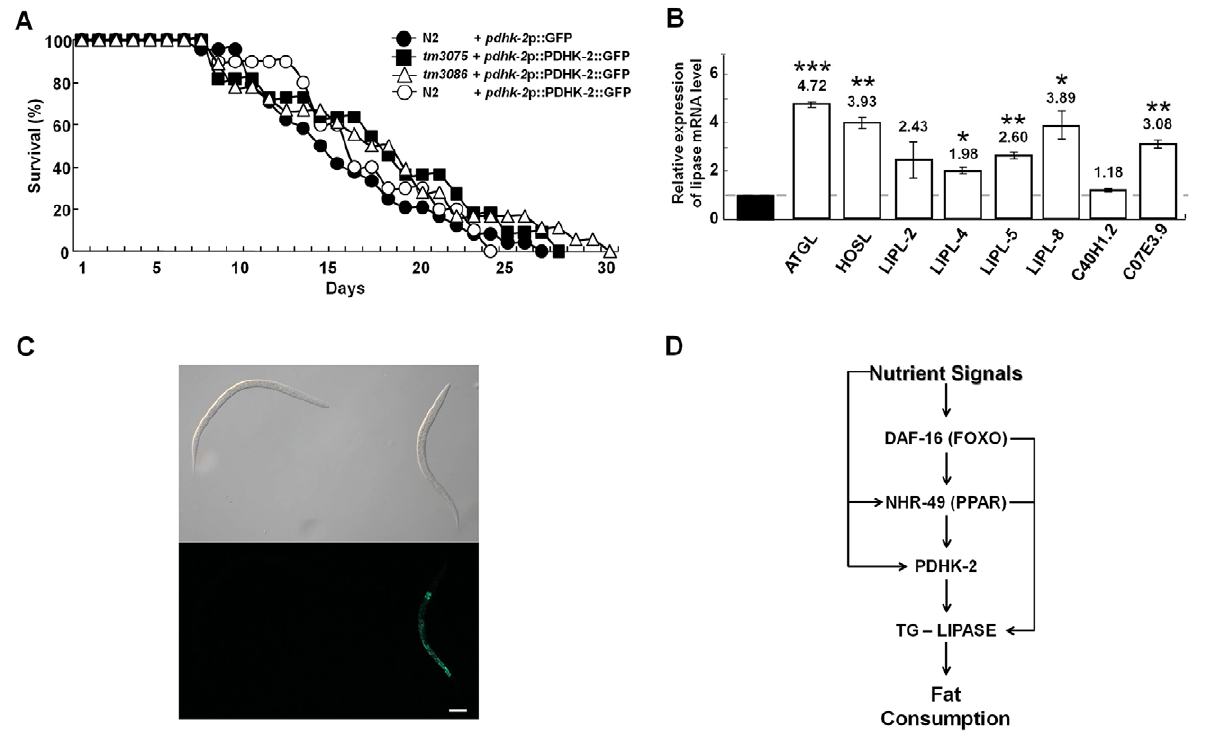
Figure 5. Effect of PDHK-2 overexpression. ( A ) Lifespan analysis of PDHK-2 overexpression in N2 wild-type. pdhk-2 p::PDHK-2::GFP was microinjected into N2 worms and the pdhk-2 mutants, tm3075 and tm3086 ; N2 injected with pdhk-2 p::GFP was used as a control. ( B ) Changes in lipase expression in PDHK-2-overexpressing N2 worms after 12-hour under starvation conditions. All data were normalized to control worms under 12-hour starvation conditions. * p , 0.05, ** p , 0.01 and *** p , 0.001 compared with the control. The values represent means [ 6 SDs] from two independent experiments. ( C ) Effect of PDHK-2 overexpression in daf-2(e1370) dauer stage worms. In the lower panel, normal dauer worms (on the left) do not express GFP, whereas worms exhibiting abnormal dauer formation do express GFP (on the right). Scale bar: 50 m m. ( D ) Role of PDHK-2 under nutritionally adverse conditions in C. elegans . Shown is the proposed role of PDHK-2 in the maintenance of fat reservoirs in starved or dauer larvae, which depend on their fat supply for long-term survival. Nutrient signals act through DAF-16 and/or NHR-49 (or through a separate,